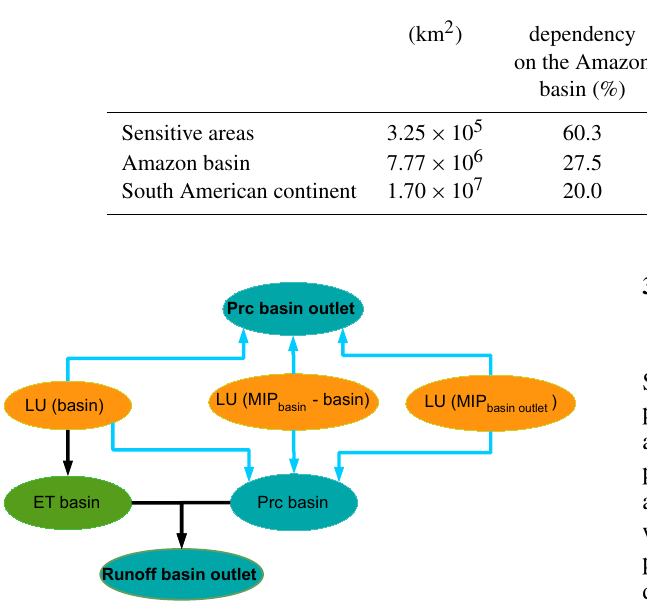
Figure 5. Influence of land use (LU) in different spatial domains (orange ellipses) on runoff and precipitation (cyan blue ellipses) of the outlet of the basin. Light blue arrows show influences via moisture recycling (“aerial rivers”); black arrows represent surface- bound relations. ET denotes the annual evapotranspiration of the basin and Prc stands for